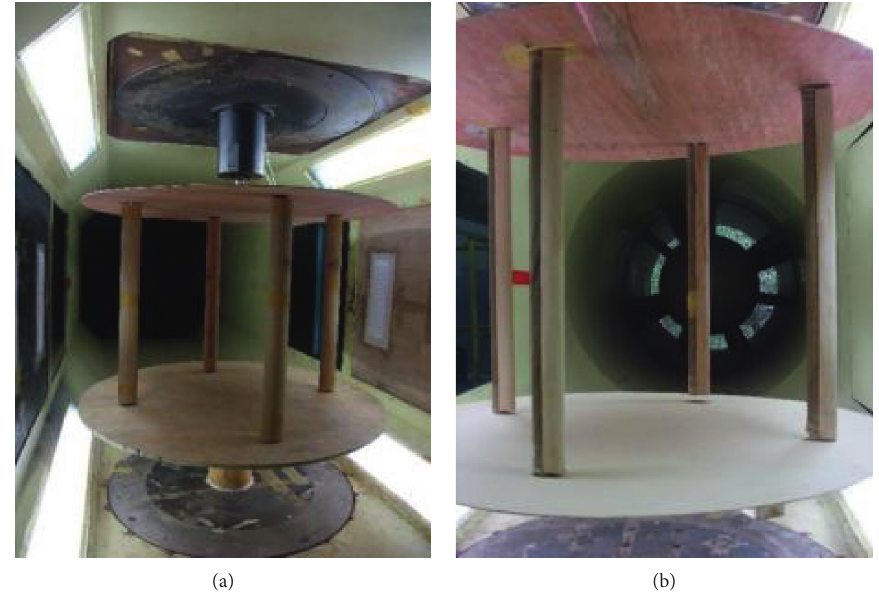
Figure 2: Wind tunnel test model of an iced quad bundle